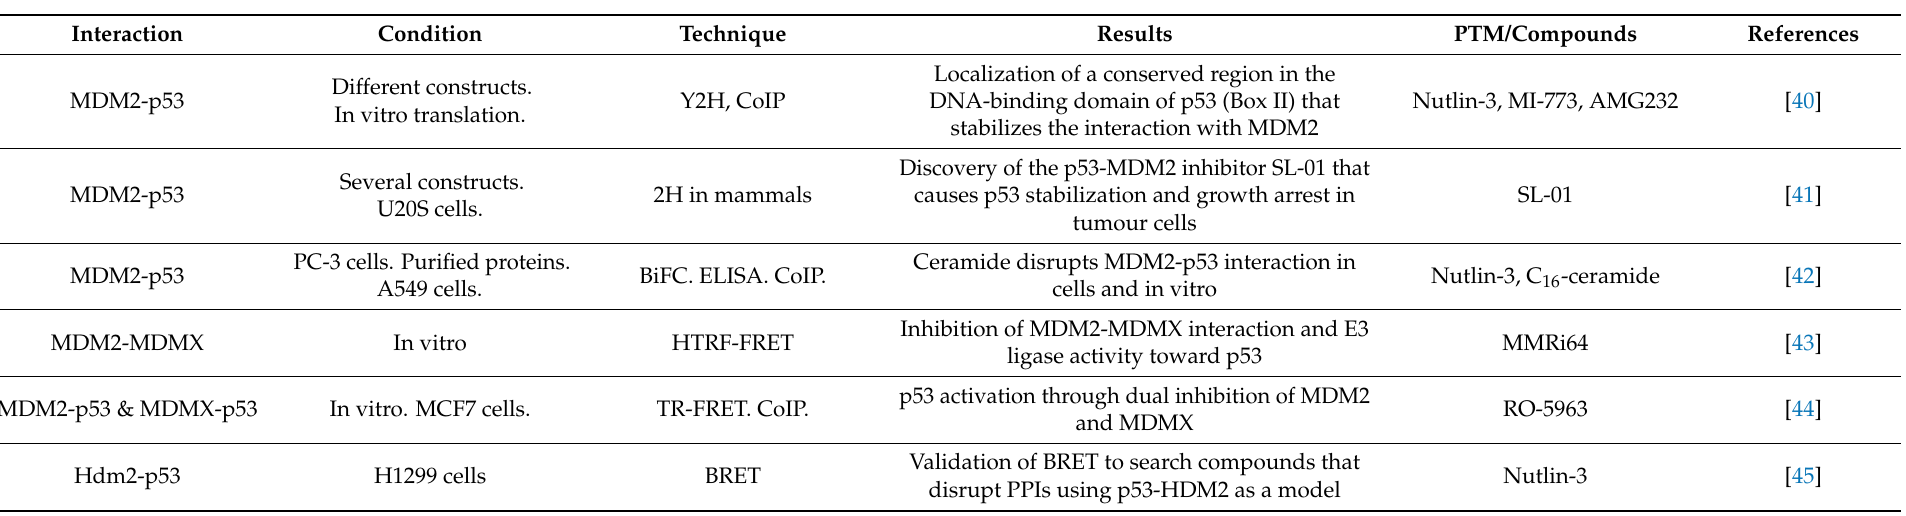
Table 2. Examples of different molecules that disrupt or control the PPIs in the p53 pathway described using “classic” PPI